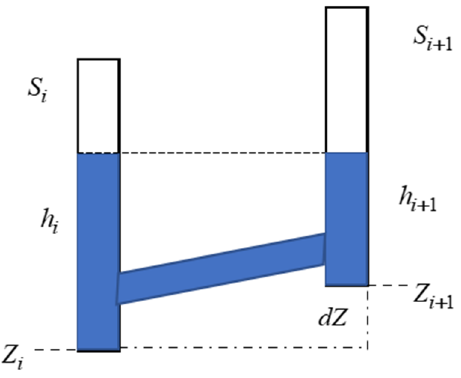
Figure 1. The HLS rule.